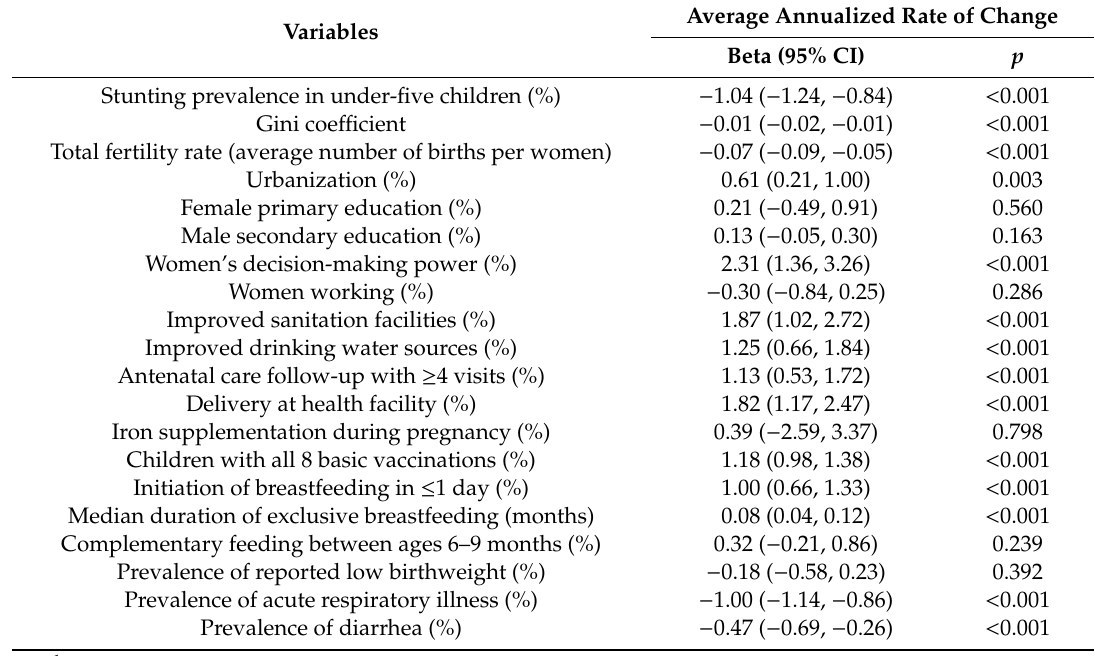
Table 3. Trends in stunting prevalence and potential determinants across survey-rounds ( n = 50) 1.